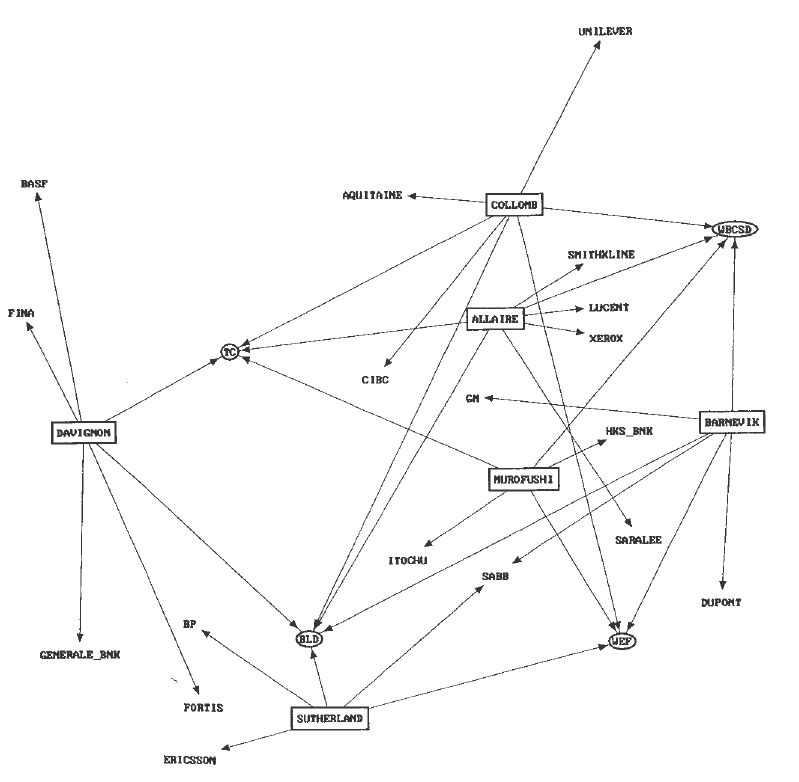
Figure 1 – The Nucleus of Six Transnational Linkers and their Multiple Figure 2 – The Core of 17 Corporate Directors with Multiple